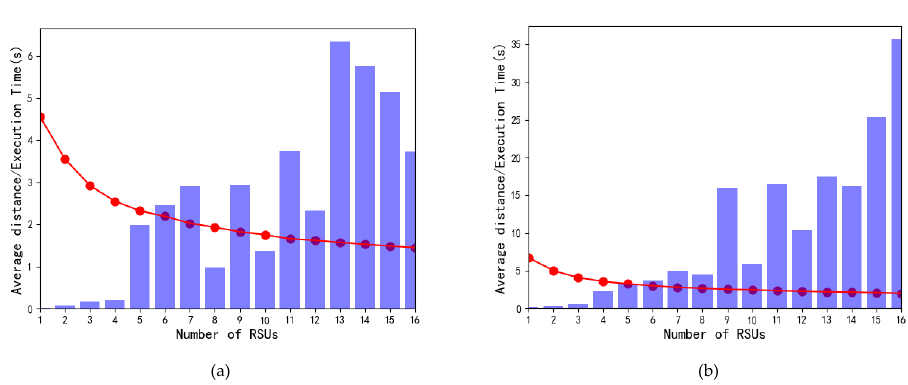
Figure 16. Distance/execution time (bar) changes over the number of Roadside Units (RSUs): ( a ) 8 × Figure 16. Distance / execution time (bar) changes over the number of Roadside Units (RSUs): 8 intersections; ( b ) 12 × 12 intersections. ( a ) 8 × 8 intersections; ( b ) 12 × 12 intersections.